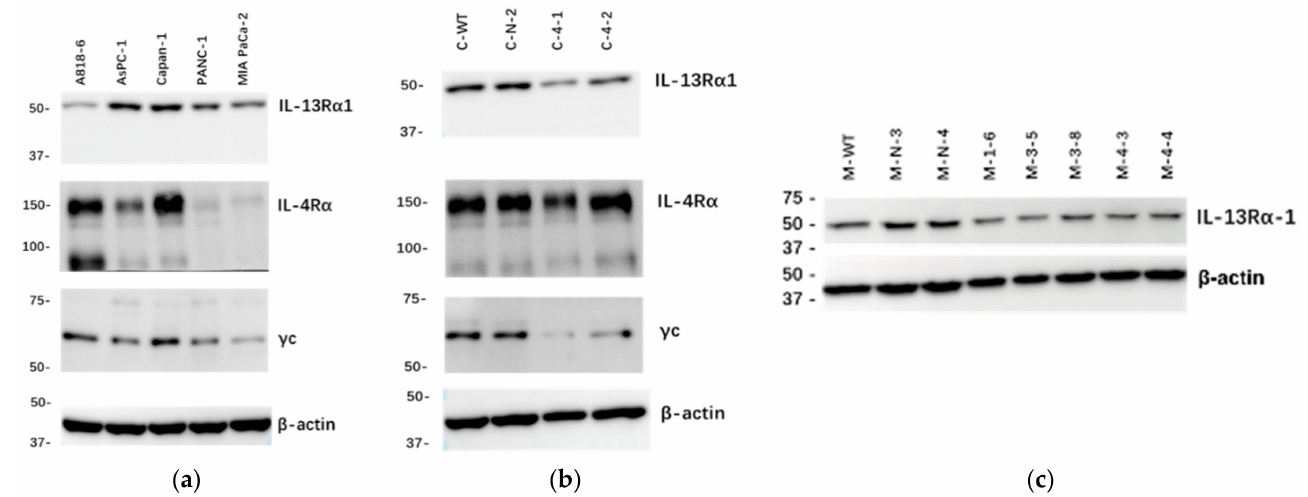
Figure 1. Immunoblot analysis of IL-13R α 1, IL-4R α and γ c chains. Expression of IL-13R α 1, IL-4R α , and γ c was determined in cultured pancreatic cell lines A818-6, AsPC-1, Capan-1, PANC-1 and MIA PaCa-2 ( a ), and sham-transfected clone C-N-2 and C-KD clones ( b ) by Western blot; ( c ) Expression of IL-13R α 1 chain in M-WT, sham-transfected clones and M-KD clones. Representative blot